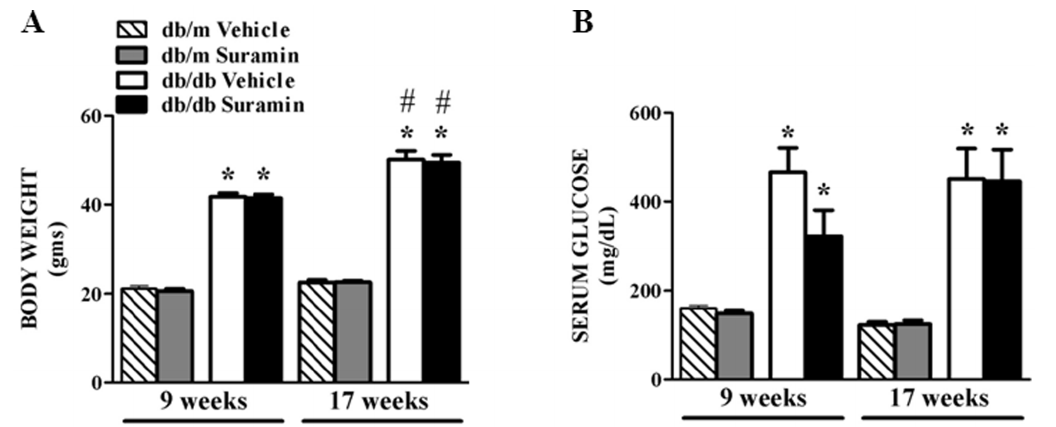
Figure 1. Effect of delayed administration of suramin on body weights and serum glucose levels in 9/17 week db/db mice. Non- diabetic db/m heterozygous mice of 8/16 weeks and diabetic db/db homozygous mice of 8/16 weeks, respectively, were treated with either saline vehicle or 10 mg suramin/kg (i.v., dissolved in saline). Mice in all groups were terminated a week later. ( A ) Body weights; and ( B ) Serum glucose levels; in 9 and 17 week non-diabetic and diabetic mice 6 suramin intervention, respectively, were measured. Data are expressed as mean 6 SE (n=6–10). * Significantly different from respective non-diabetic db/m mice. ( p # 0.05). # Significantly different from 9 week diabetic db/db mice. ( p # 0.05).